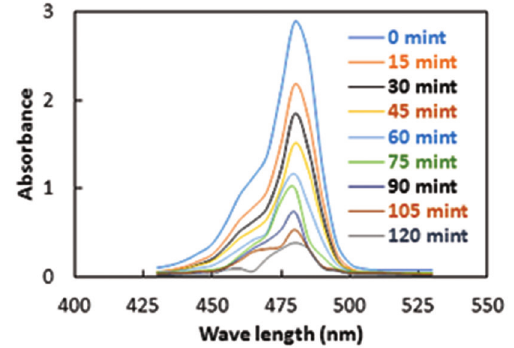
Figure 6: Visible spectra of solution of methyl orange treated with Ag-Co O catalyst at different time intervals. 3 4